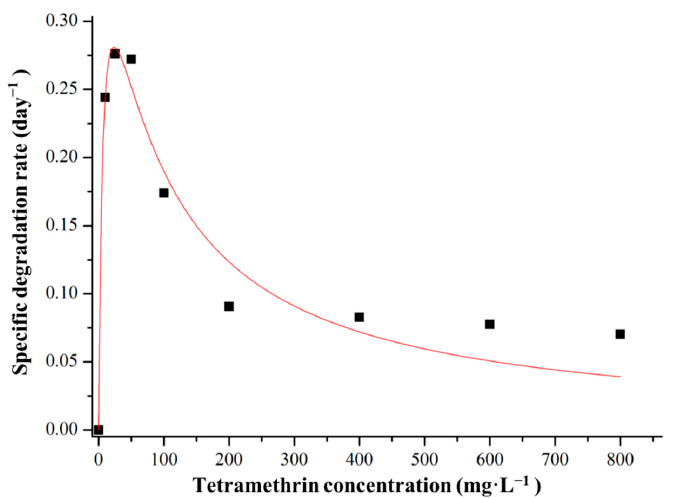
Figure 4. Relationship between the initial tetramethrin concentration and specific degradation rate using strain A16. using strain